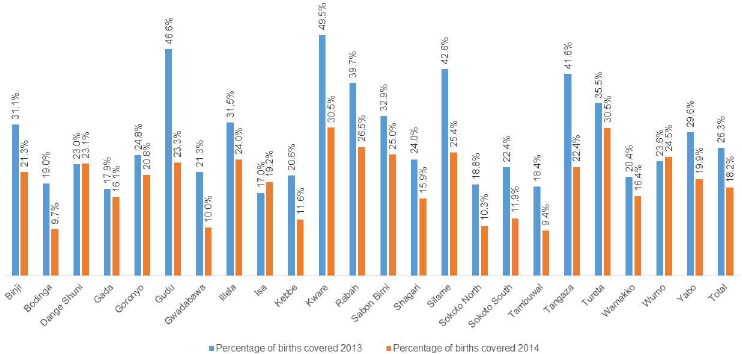
Fig 2. Percentage of mother’s receiving misoprostol, by LGA in two time periods: April-December 2013 and January-December 2014.